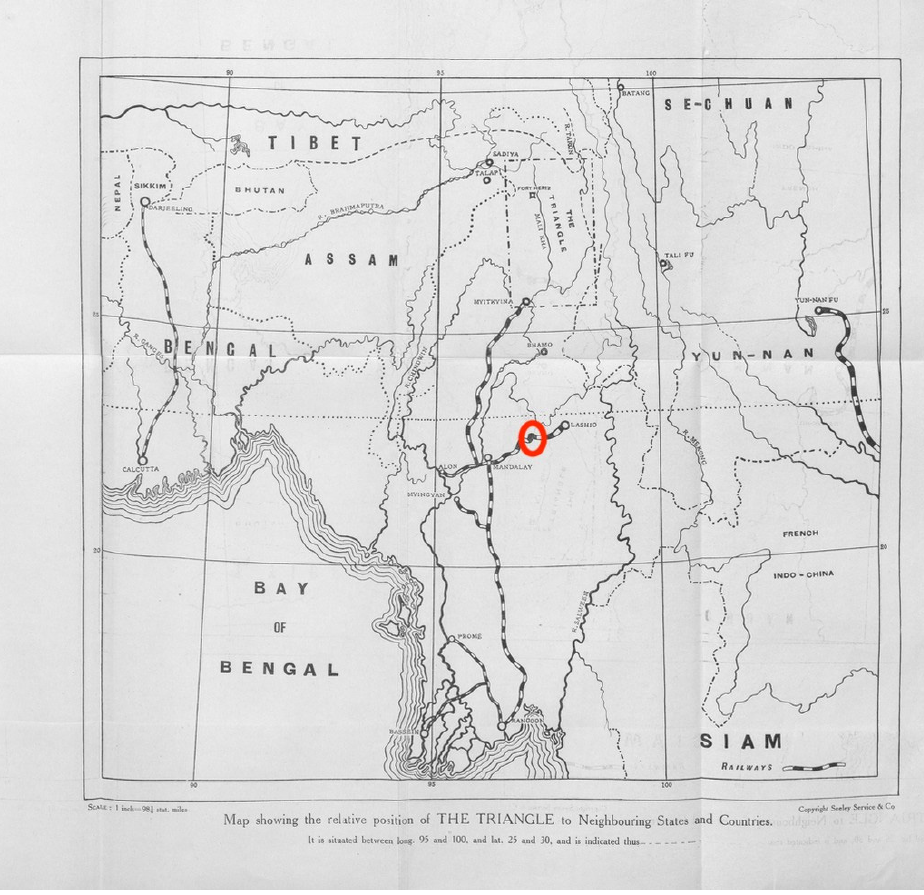
Figure 1. Colonial map showing the Burma Railway system and nearby “Yun-nan”, Siam (Thailand), and French Indochina. The red circle is the vicinity of the Gokteik Viaduct. Source: (Horton 1899).